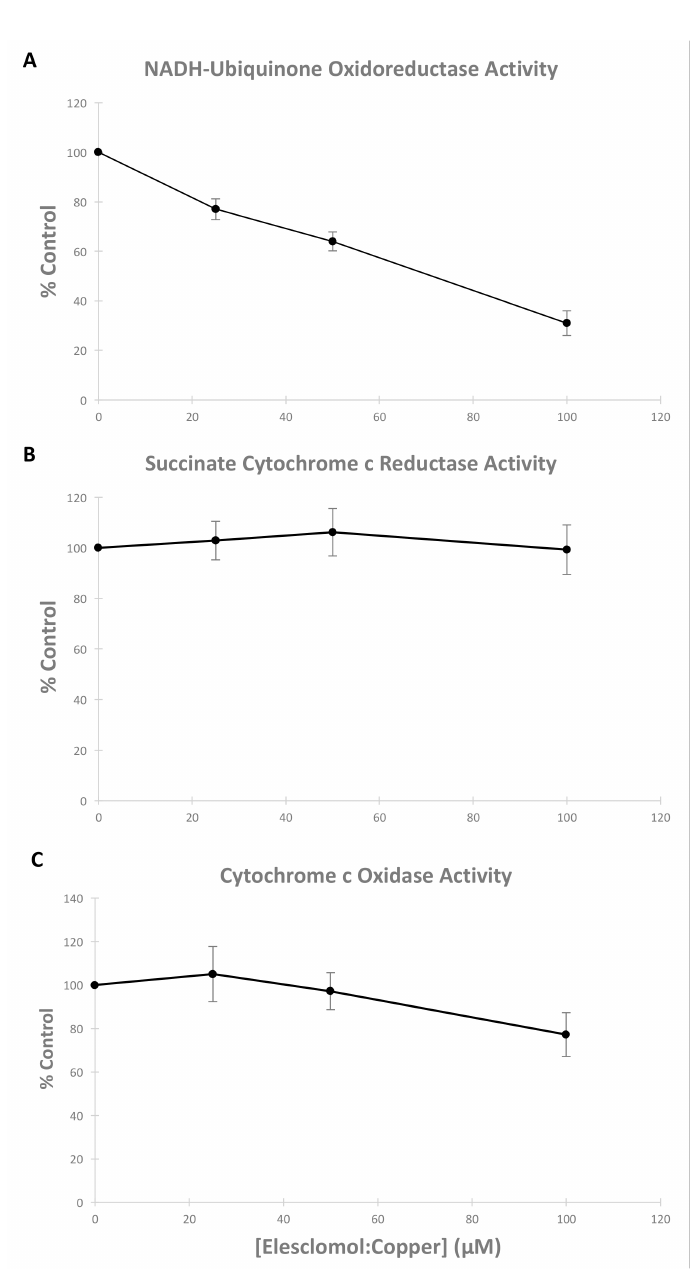
Figure 7. E ff ect of varying concentrations of E:C on mitochondrial respiratory enzyme complex activity. ( A ) NADH-ubiquinone oxidoreductase activity, ( B ) succinate cytochrome c reductase activity, and ( C ) cytochrome c oxidase activity were measured in freeze-thawed preparations of bovine mitochondria